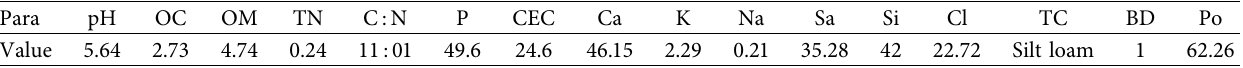
Table 3: Physico-chemical properties of pre-experimental